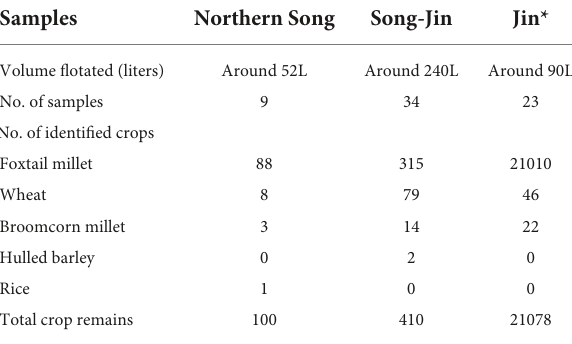
TABLE 2 Results of counts of crop remains in the floatation samples from ZKS